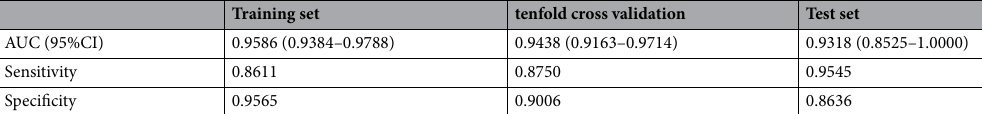
Table 3. Performance of metabolite biomarker panel for distinguishing patients with GC from healthy individuals in the training set, tenfold cross validation, and test set. GC, gastric cancer; AUC, area under receiver operating characteristic